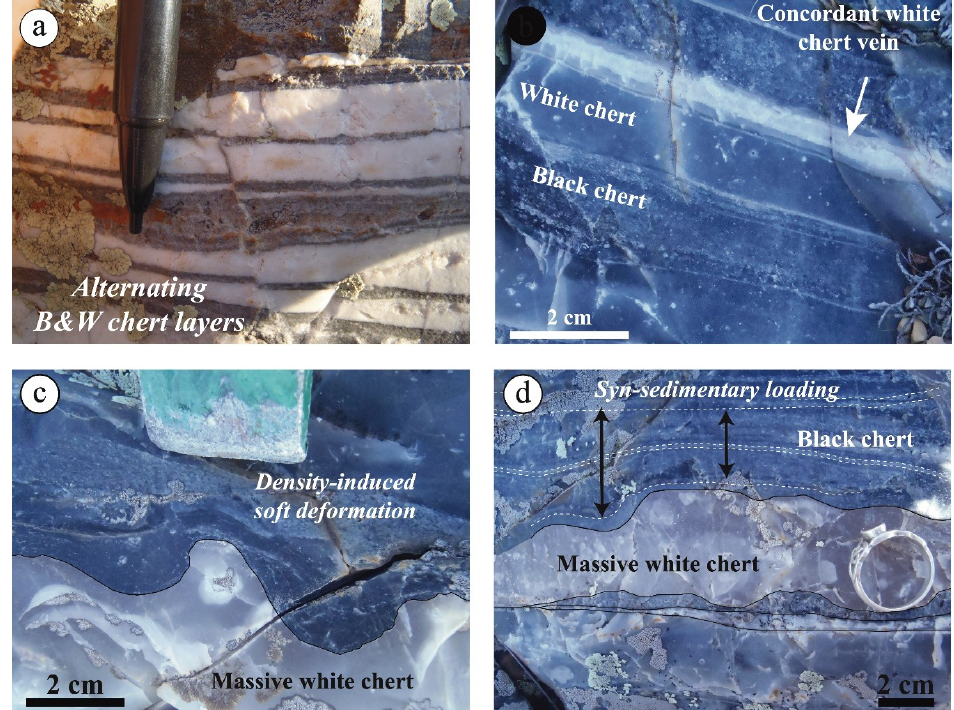
Figure 2. ( a ) Weathered and ( b ) fresh outcrops of typical banded cherts’ facies showing regular alternations of particle-rich, thinly laminated black chert with particle-free, white chert. ( b ) Example of concordant white chert veins of well-crystallized quartz with colloform structures. ( c , d ) The top a of white layer is commonly soft-deformed underneath a denser black chert band. ( c ) The contact is sharp but undulating in a way similar to load-cast structures. ( d ) Thin laminations in the overlying black chert follow the undulations, then become regular and undeformed a few centimeters away from the